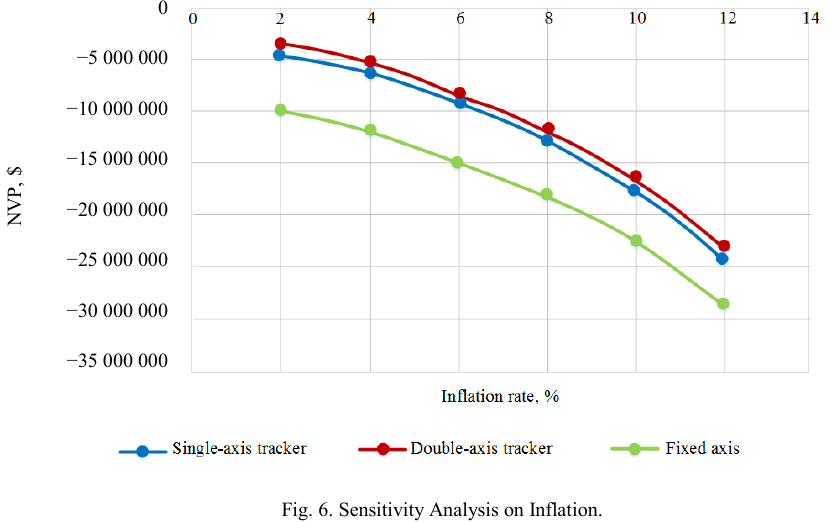
Fig. 6. Sensitivity Analysis on Inflation.